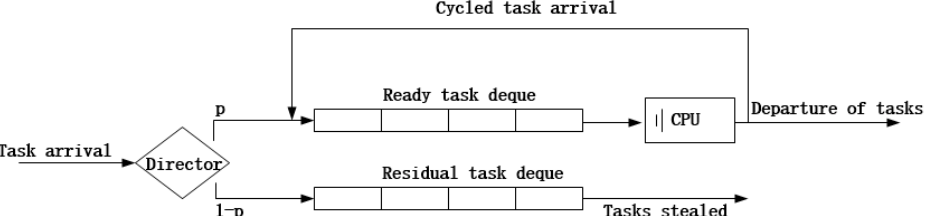
Figure 6. Over-loaded FCN model ( p < 1).